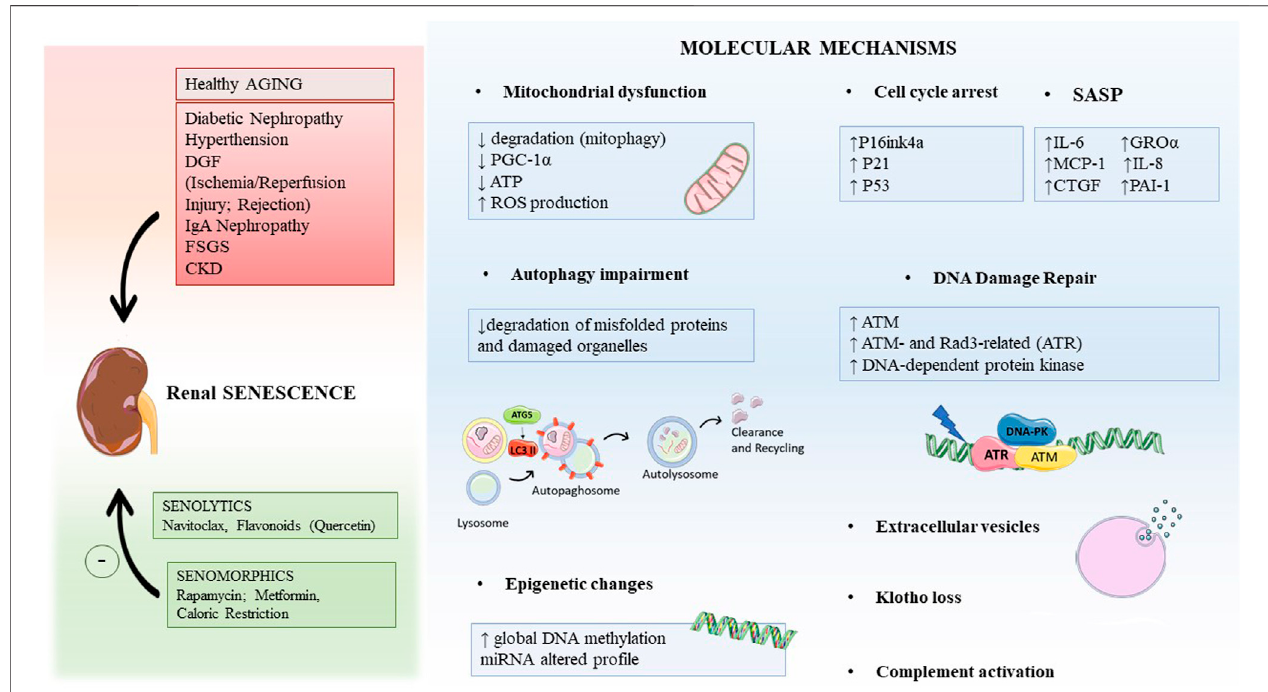
FIGURE 1 | Graphical abstract indicating the main causes leading to renal aging and possible therapeutic intervention strategies (in the left). The key molecular mechanisms inducing renal aging are mitochondrial dysfunction, autophagy, epigenetic changes, DNA damage repair (DDR), extracellular vesicles, and others. Abbreviations: DGF, delay graft function; FSGS, focal segmental glomerulosclerosis; IgAN, IgA nephropathy; CKD, chronic kidney disease; PGC-1 α , peroxisome proliferator-activated receptor γ coactivator-1; ROS, oxygen reactive species; GRO α , growth-regulated oncogene α ; MCP-1, monocyte chemoattractant